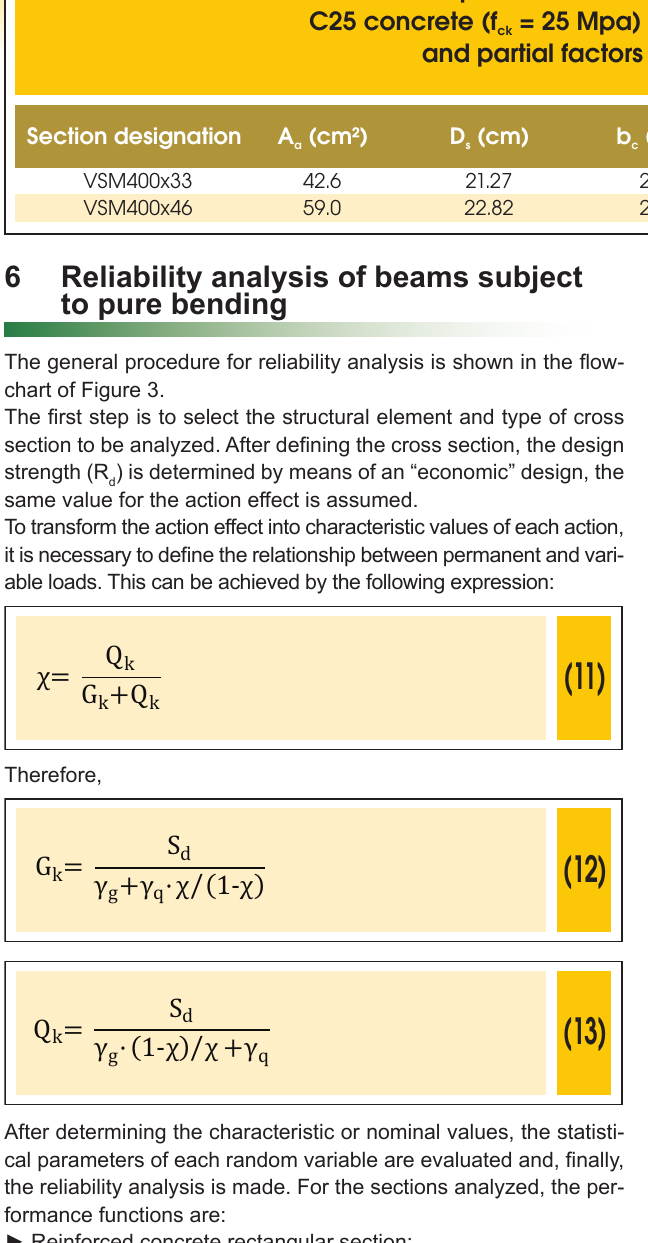
Table 5 – Steel-concrete composite sections analyzed and design resistance considering